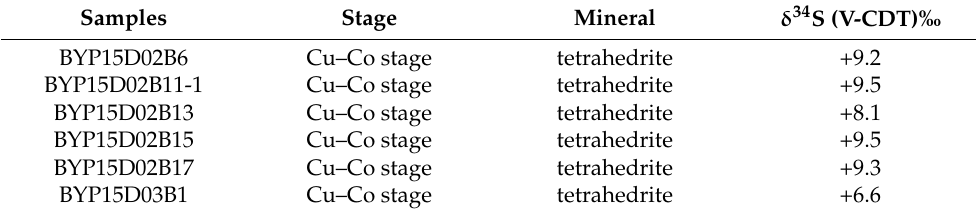
Table 2. δ 34 S (‰) isotopic data from the Baiyangping Cu–Co–Pb–Zn